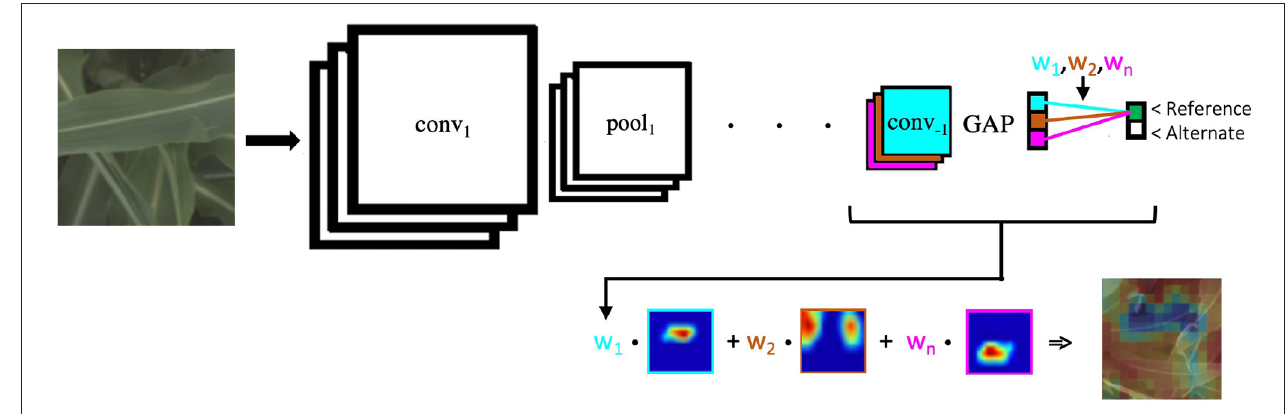
FIGURE 3 | We use a standard ResNet-50 architecture, which like many deep convolutional neural networks consists of alternating convolutional and pooling layers (with interspersed activation functions). The network ends with a final convolutional layer ( conv − 1 ), a global average pooling (GAP) operation, and then a fully connected layer, the output of which is used to make our prediction of whether an image shows a plant with a reference or alternate version of a particular genetic marker. We use the class activation mapping approach described in Zhou et al. (2016), in which the filters in the last convolutional layer are multiplied by the corresponding weights between the respective layer and the predicted output node. These weighted filters are then added up to produce a heatmap that has its highest values in important